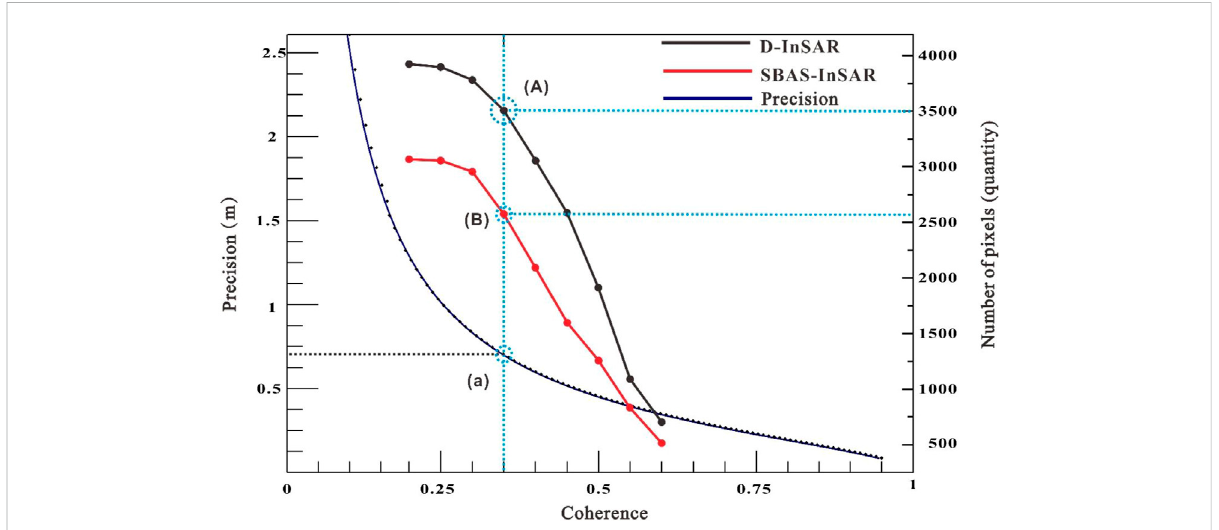
FIGURE 4 Analysis of interferometric stripe displacement accuracy and the number of image elements for successful phase decoupling under different coherence thresholds.